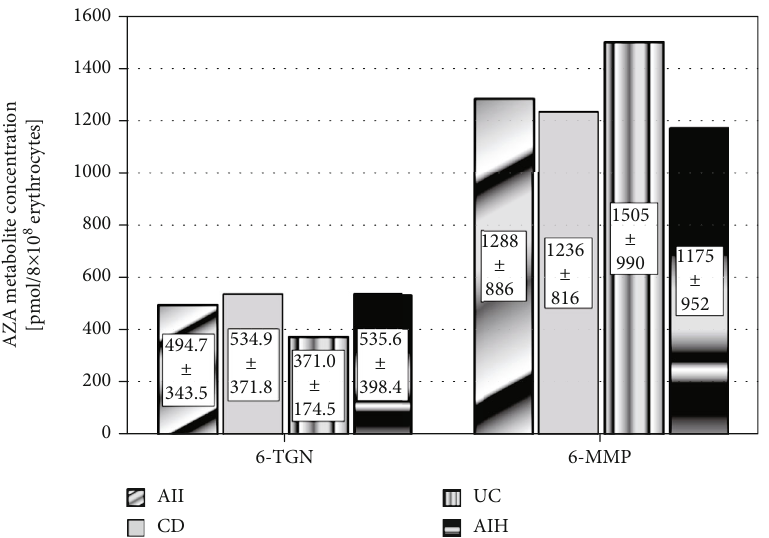
Figure 3: Interpretation of metabolite levels in the group receiving AZA. AZA: azathioprine; CD: Crohn ’ s disease; UC: ulcerative colitis; AIH: autoimmunological hepatitis; 6-MMP: methylmercaptopurine; 6-TGN: